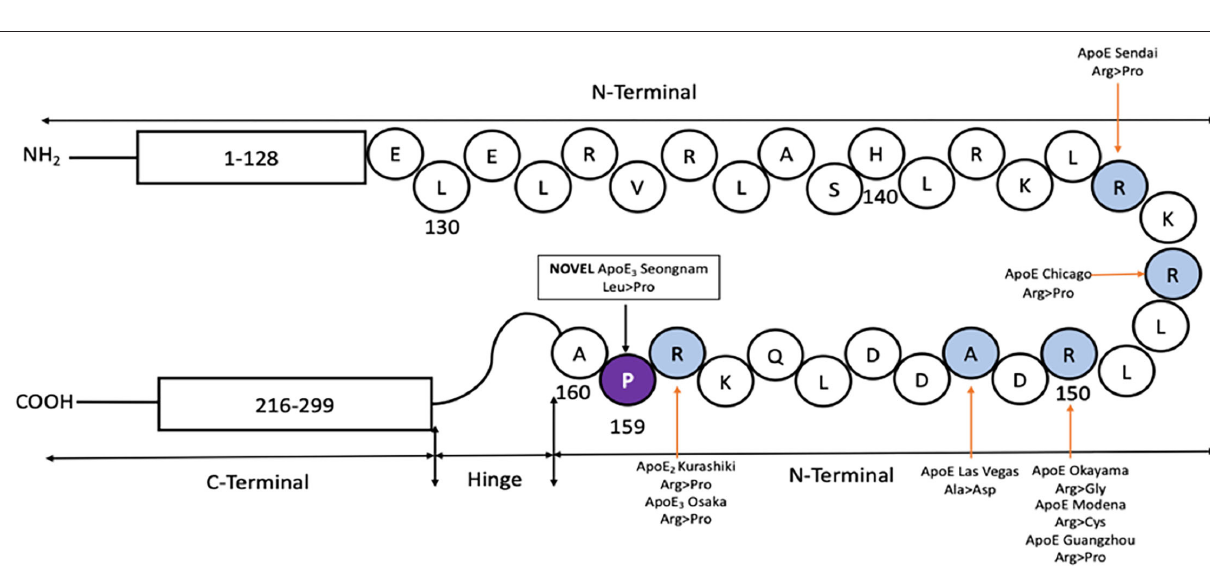
ABCA7, LRRK2, HIP1R, SINJ1, and APLP2, APOE may play